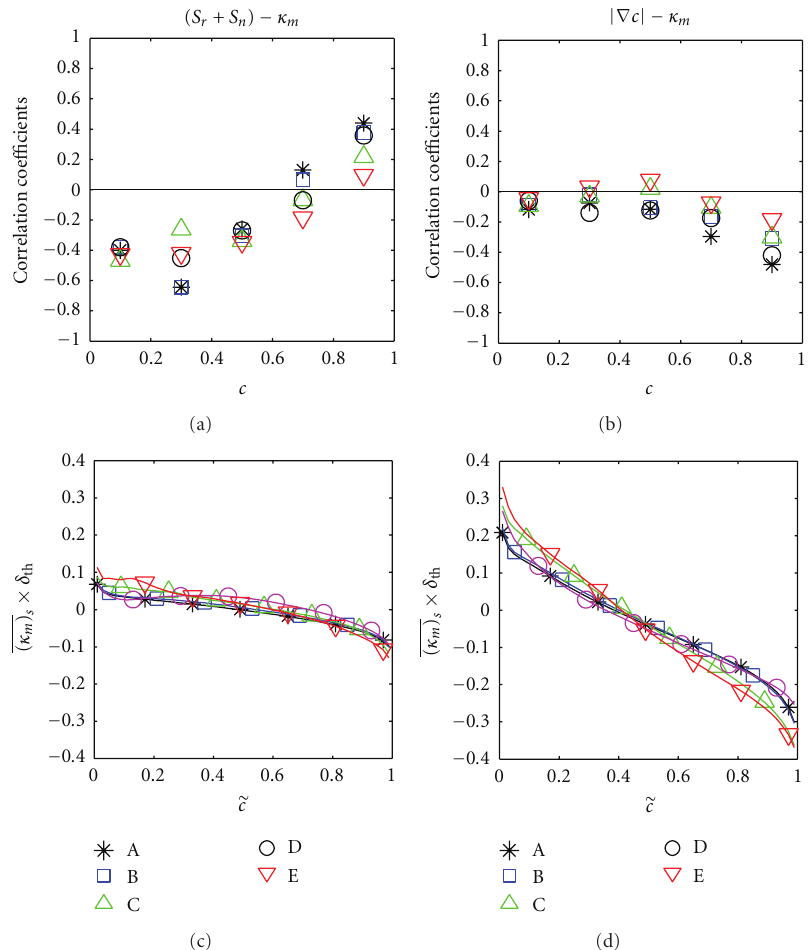
Figure 4: Correlation coe ffi cients for the (a) ( S r + S n ) − κ m and (b) |∇ c |− κ m correlations for c = 0 . 1,0 . 3,0 . 5,0 . 7 and 0.9 isosurfaces for cases A–E. Variations of ( κ m ) s × δ th conditionally averaged in bins of (cid:3) c across the flame brush for (c) Δ = 8 Δ m ≈ 0 . 8 δ th and (d) Δ = 24 Δ m ≈ 2 . 4 δ th